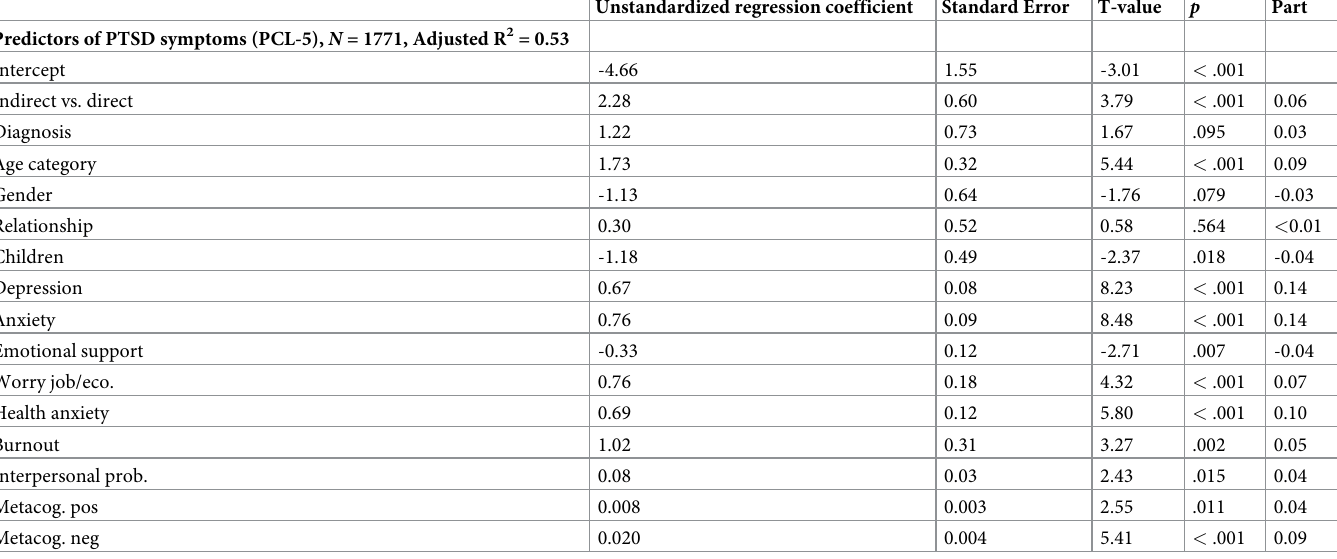
Table 5. Risk factors for PTSD symptoms identified by multiple regression